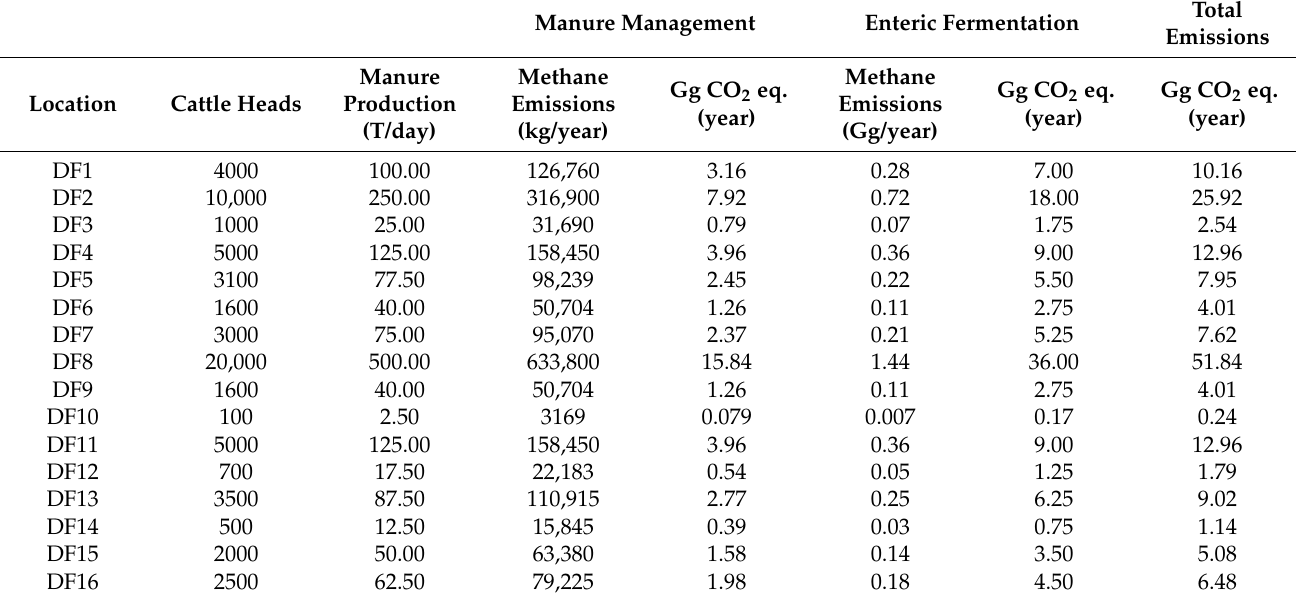
Table 3. Inventory of methane emissions from each livestock